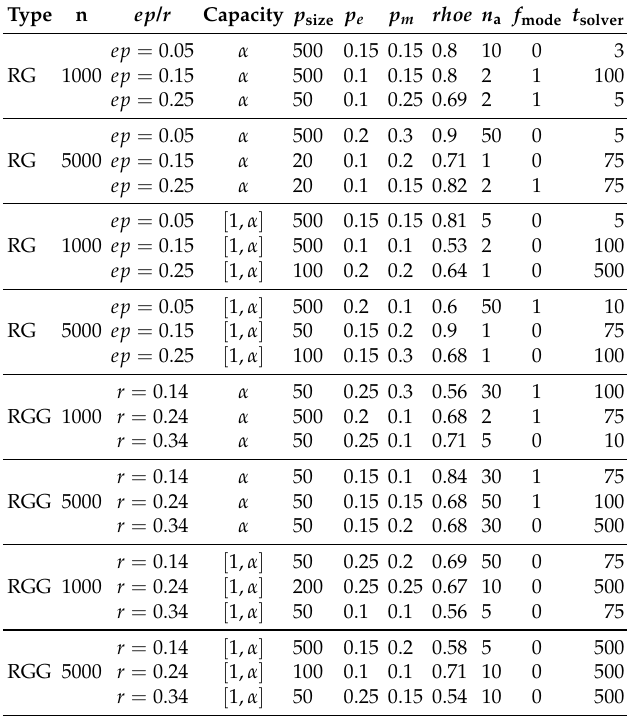
Table 4. B ARRAKUDA parameter values generated by irace for the new data set of large problem